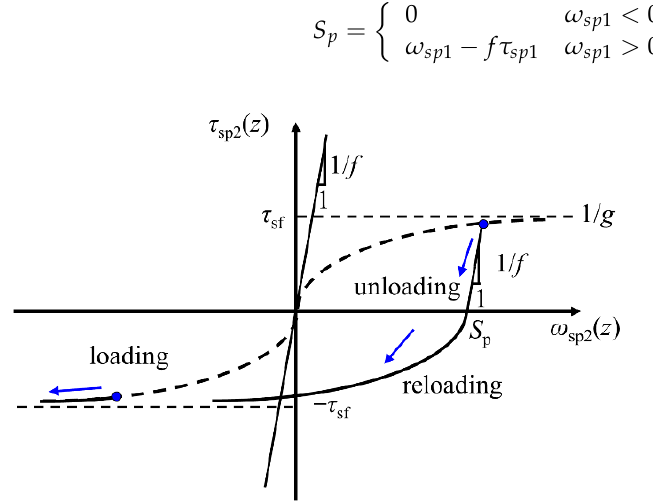
Figure 4. Hyperbolic load-transfer curve for pile shaft during pile loading.